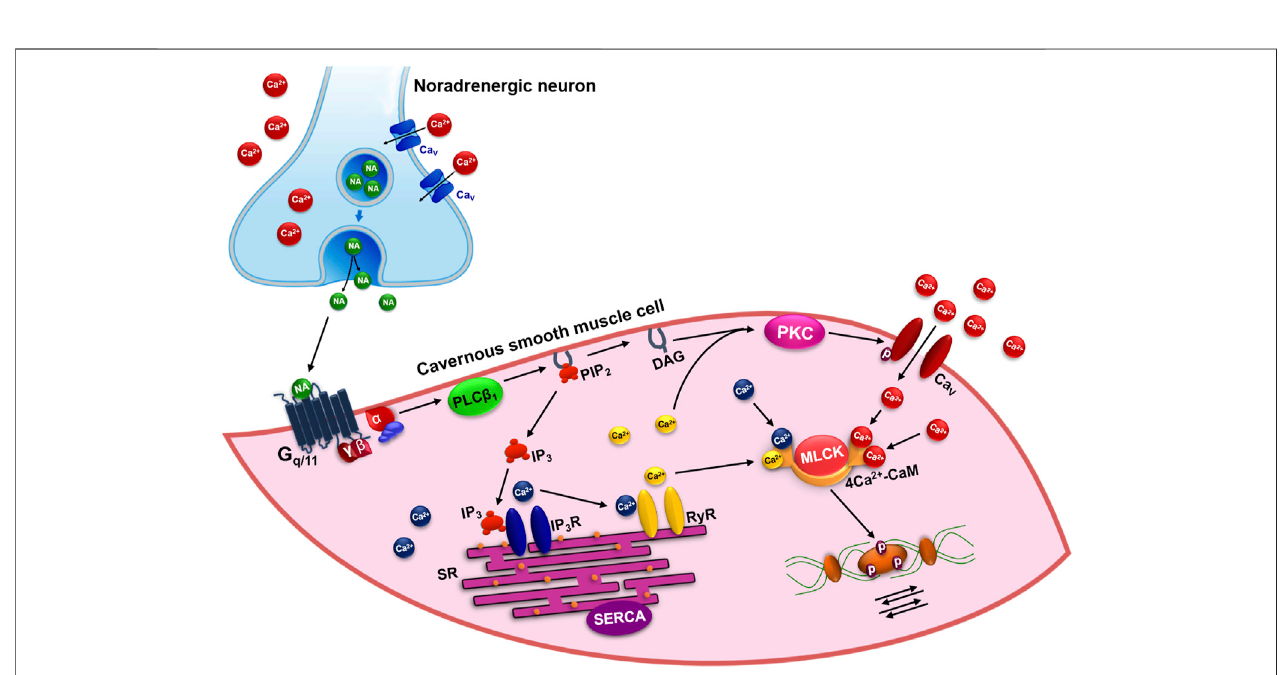
FIGURE 2 | Pharmacomechanical mechanism of contraction in the cavernous smooth muscle by activation of G q/11 -PLC β 1 pathway. NA: noradrenaline; Ca V : voltage-dependent Ca 2+ channels; PLC β 1 : phospholipase C β 1 ; PIP 2 : phosphatidylinositol 4,5-bisphosphate; DAG: diacylglycerol; IP 3 : inositol 1,4,5-trisphosphate; IP 3 R: IP 3 receptors; RyR: ryanodine receptors; SR: sarcoplasmic reticulum; SERCA: Ca 2+ -ATPase of SR; PKC: Ca 2+ -dependent protein kinase; MLCK: myosin light chain kinase; CaM: calmodulin protein.